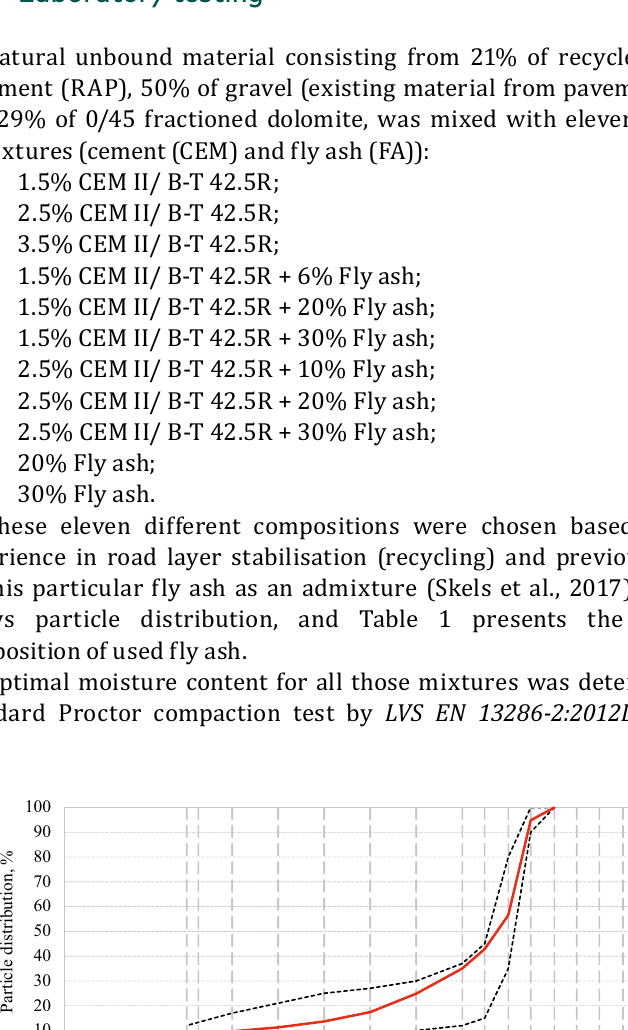
5245 . 6811 . 21622 . 431 . 5456390 1 0 .